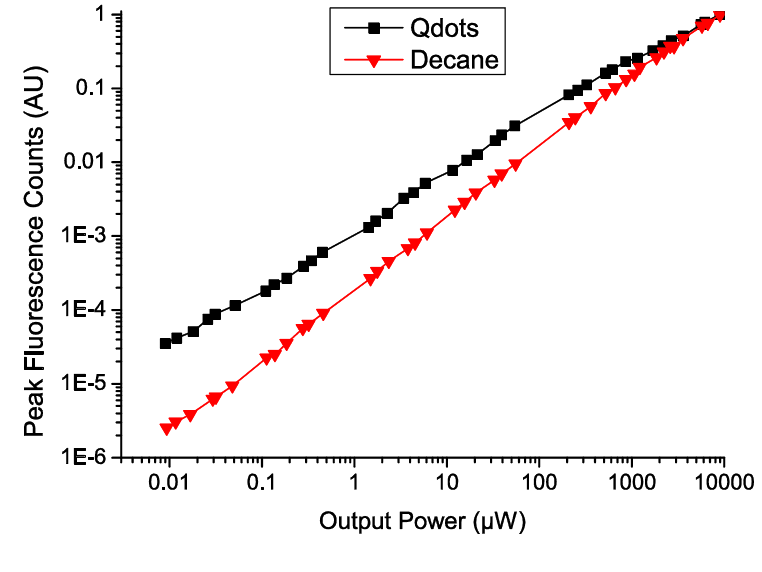
Figure 4. Peak fluorescence counts at 780 nm of both a fiber filled with a solution of Qdots in Decane (black squares) and a F2HT-core WW fiber filled with plain decane (red triangles) without Qdots added. The fluorescence counts have been normalized to 1 at 8.95 mW output